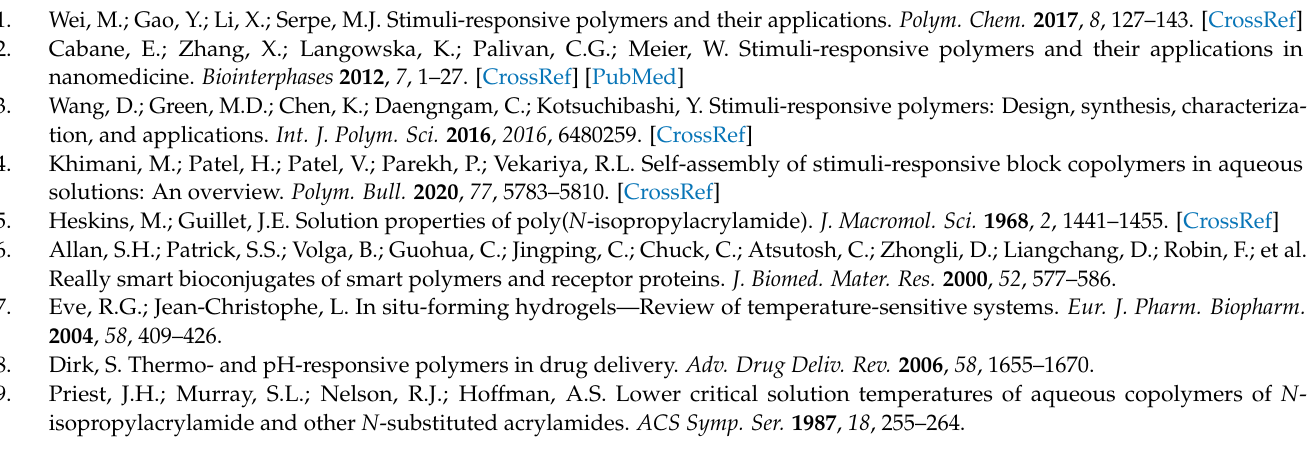
for the resonance peaks; Figure S4. GPC elution curves for PMPC (—) and PAAc (—) using a mixed solvent of 50 mM phosphate buffer at pH 9 and acetonitrile (9/1, v/v ) as an eluent at 40 ◦ C; Figure S5. EP and EP 1/2 positions on the PAAc titration curve at C p = 5.0 g/L titrated against HCl in 0.1 M aqueous solution at 25 ◦ C: Firstly, PAAc was dissolved in 0.1 M NaOH at C p = 5.0 g/L; Figure S6. Percent transmittance (% T ) at 700 nm for PMPC/PAAc with f AA = 0.85 mixed aqueous solutions at pH 3, C p = 0.5 g/L, and [NaCl] = 0.1 M as a function of temperature with the 2nd (circle) and 3rd (triangle) heating (red) and cooling processes